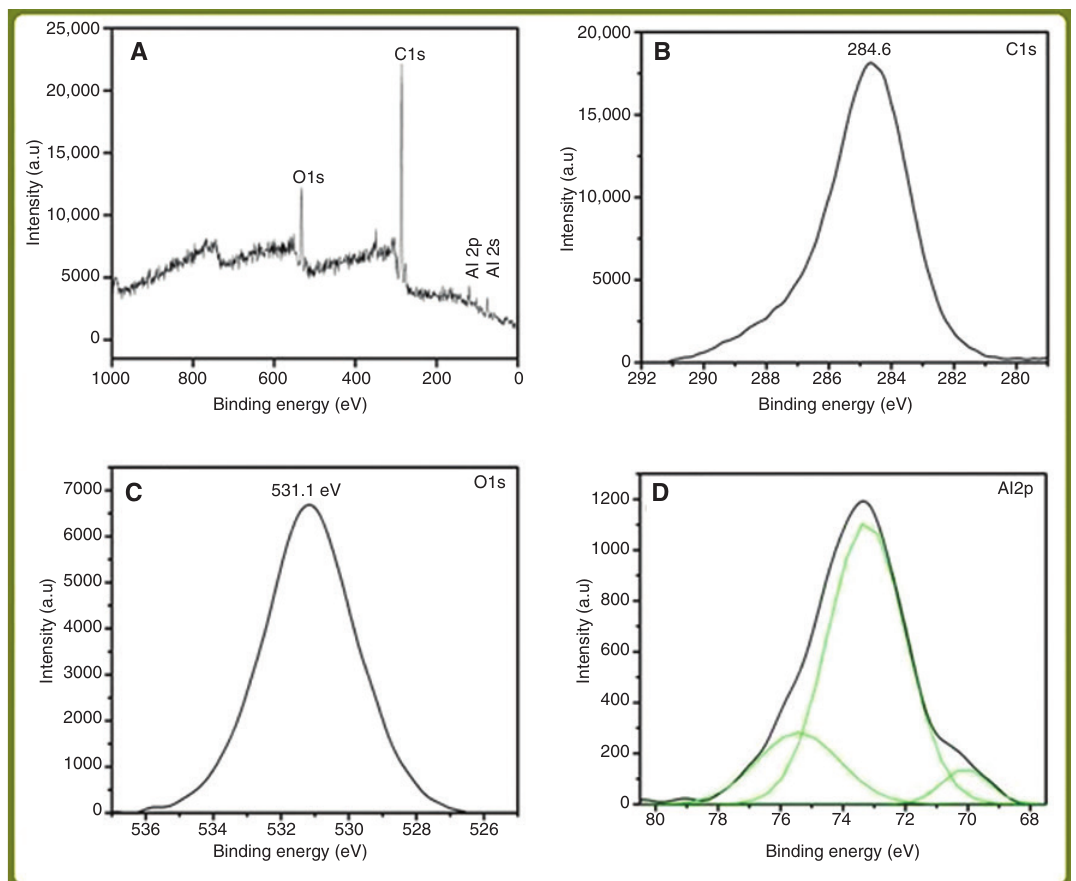
Figure 4 X-ray photoelectron (A) survey spectrum, (B) C1s core level, (C) O1s core level, and (D) Al2p core level X-ray photoelectron spec- trum of Al and Al O 2 3